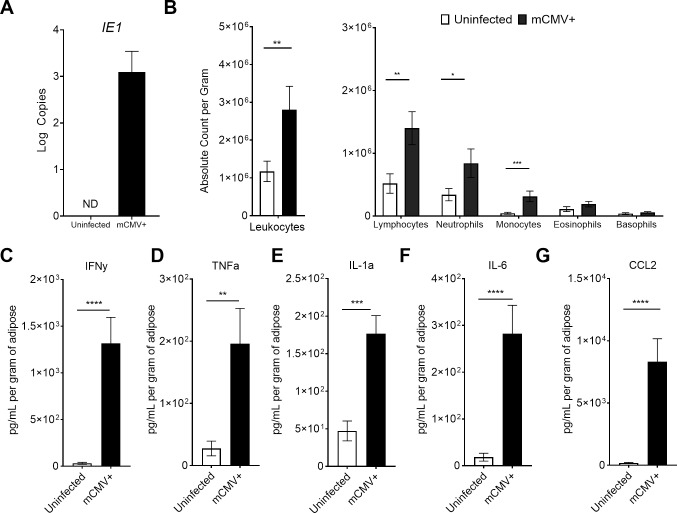
mCMV infects adipose tissue and triggers an immune response.12-week-old C57BL/6J mice were i.p. injected with 105 pfu of mCMV. (A) Adipose tissue was collected three days post infection into QIAzol reagent and RNA extracted to detect viral gene products IE1 in 50 ng of total RNA by RT-qPCR and normalized to plasmid. (B) Three days p.i., adipose tissue was processed by collagenase D digestion and stromal vascular fraction was analyzed by hemocytometer. (C-G) Mice infected from three to five days post infection were sacrificed and total adipose homogenized to analyze by BioLegend LegendPlex 13-plex Inflammation Panel. Data are pooled results of two independent experiments. n = 10 uninfected and 10 infected animals total. Error bars represent mean ± SEM. *p < 0.05; **p < 0.01; ***p < 0.001; **** p ≤ 0.0001 by unpaired two-tailed Mann-Whitney U test.